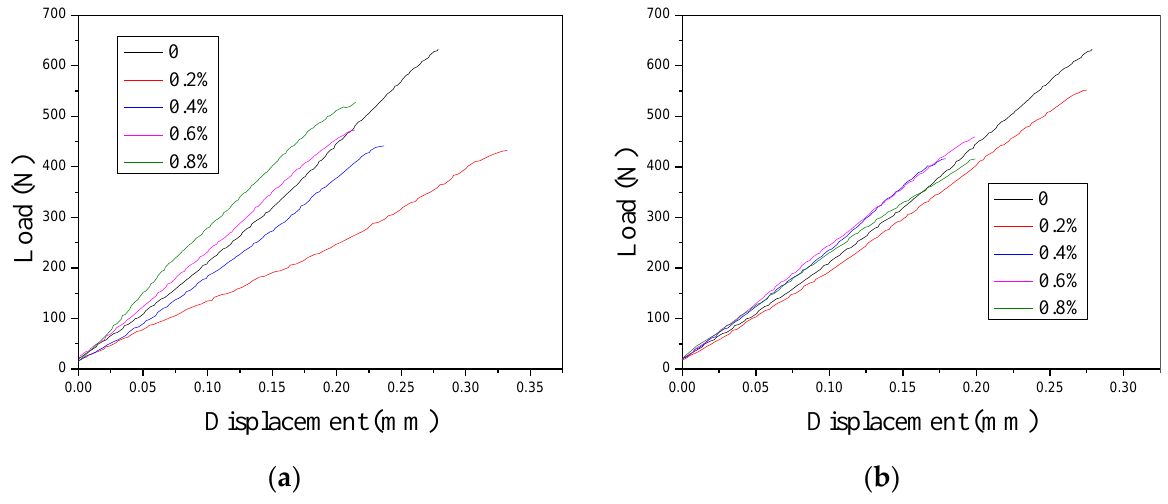
Figure 14. Load–displacement curve of the mortar: ( a ) 3-mm PP fiber, ( b ) 6-mm PP fiber.